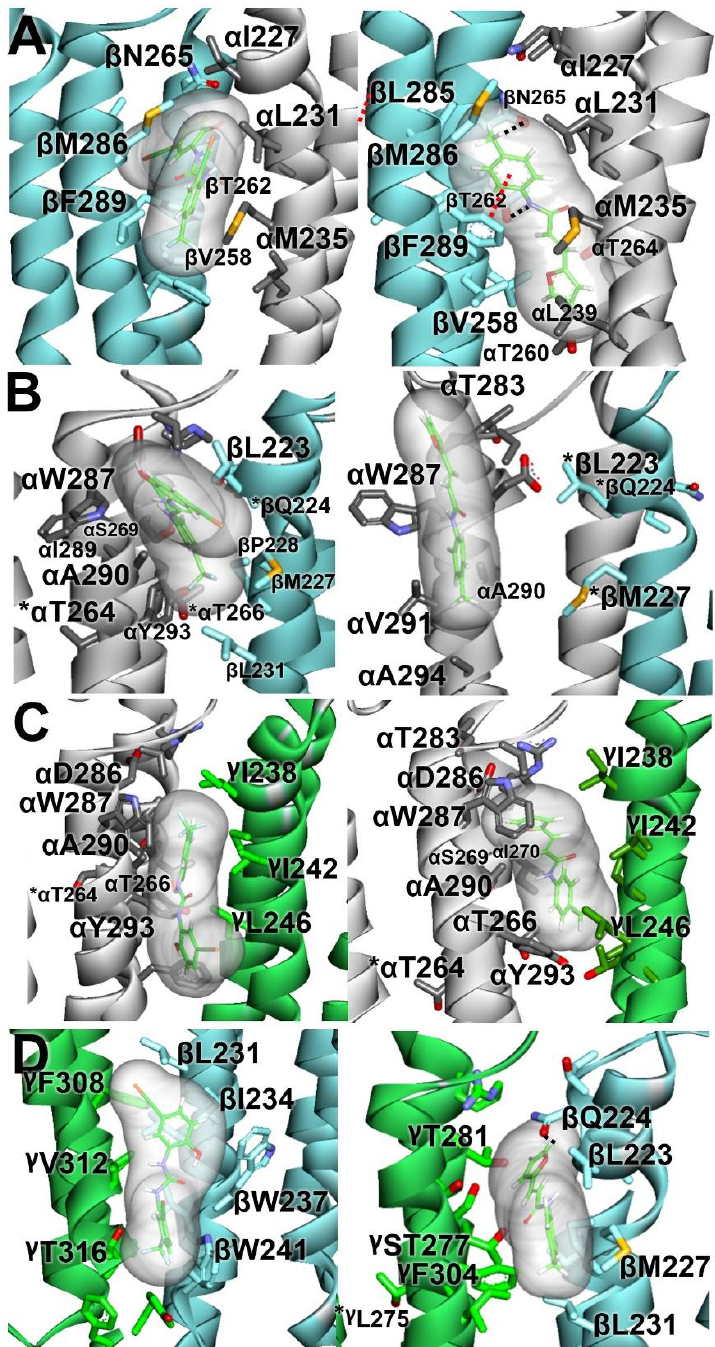
Figure 3. Molecular docking of NS-1738 (left panels) and PAM-2 (right panels) to the α1β2γ2 GABA A receptor model. Stable docking sites are shown at the β+/α− ( A ), α+/β− ( B ), α+/γ− ( C ), and γ+/β− ( D ) interfaces. Subunits (α, white; β, light-blue; and γ, green) are represented as ribbons, while ligands are represented as thin sticks surrounded by their molecular surfaces, colored by atoms, with carbon atoms in green. The interacting residues are represented by thick sticks, colored by atoms, with H atoms omitted for clarity. Black dotted lines represent hydrogen bonds. Red dotted lines represent π–π interactions. * Residues were tested with mutational analysis but were not predicted to interact with the ligand.